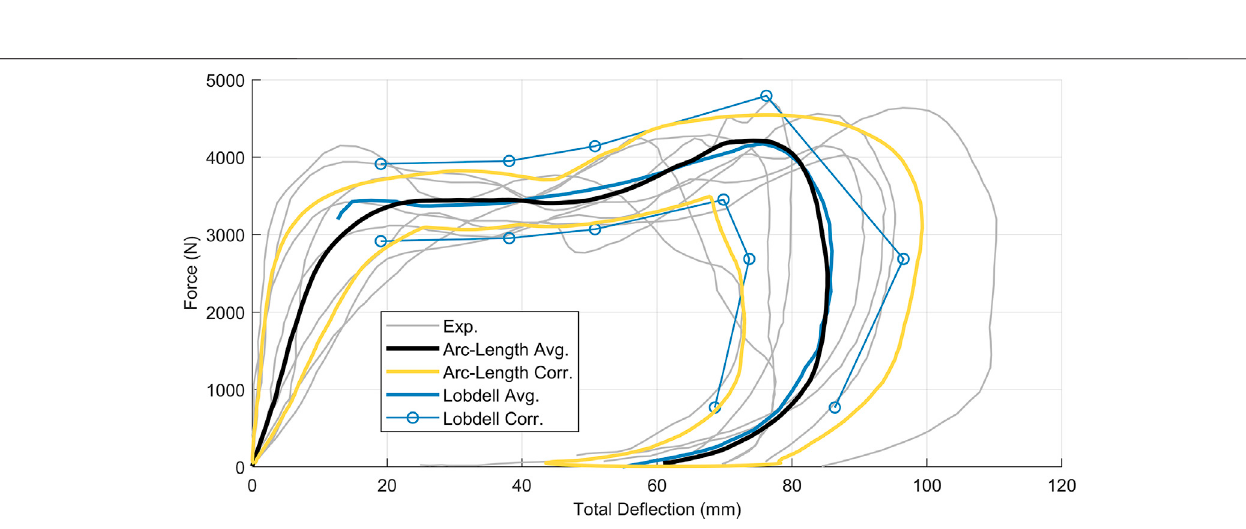
Frontiers in Bioengineering and Biotechnology |